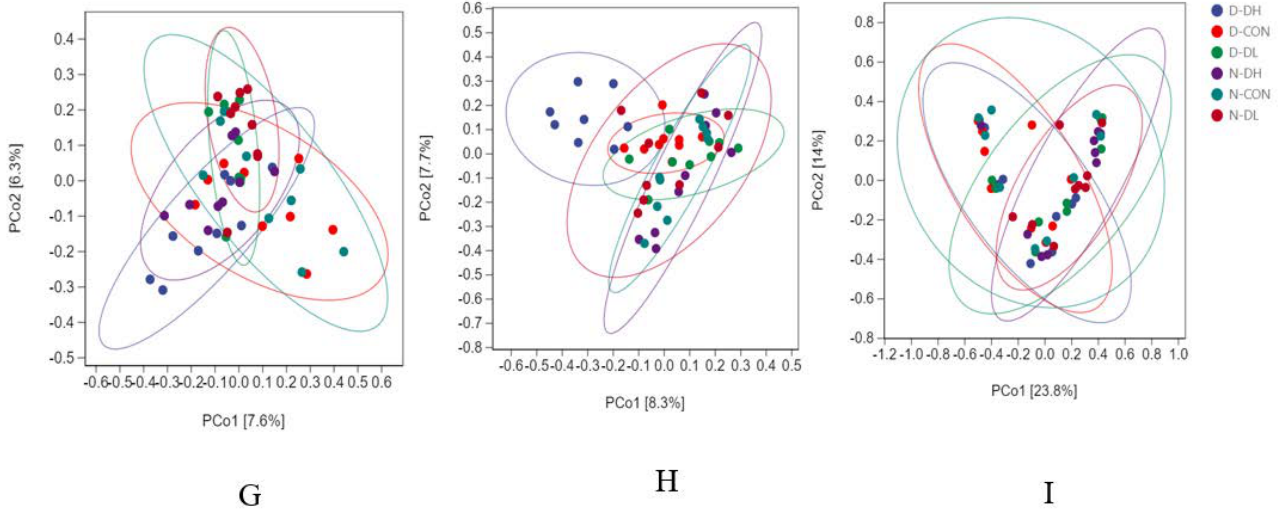
Figure 3. Structure of rumen microflora of mutton sheep fed with different diets. PCoA is used to assess the differences in bacterial community composition between samples and to visualize the potential aggregation of samples. ( G – I ) represent the community structure of bacteria, fungi and protozoa, respectively. Each point represents a unique sample. D − DH, D − CON, and D − DL represent 12 h of the and N − DH, N − CON and N − DL represent 12 h of the night (and are distinguished by blue, red, green, and purple colors. Based on the OTU composition and abundance, the unweighted UniFrac distance was used for the calculations. The percentage in the brackets of the coordinate axis represents the proportion of the sample difference data (distance matrix) that can be explained by the corresponding coordinate axis. A projection analysis is suggested (the distance is not to be taken literally): the closer the projection distance of the two points on the coordinate axis, the more similar the community composition of the two samples in the corresponding dimension. On the contrary, the greater the distance between the two points, the lower the similarity between them.